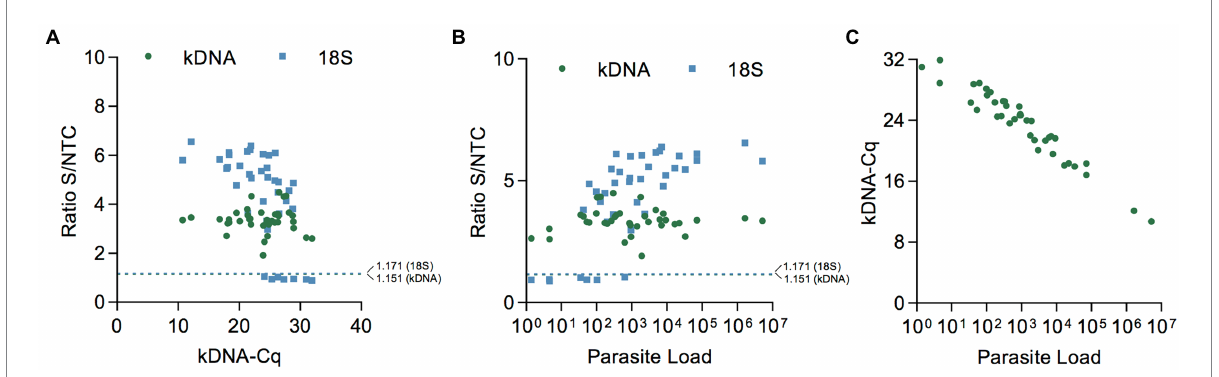
FIGURE 6 Performance evaluation of PCR/CRISPR assays across the range of parasite load levels in clinical samples. (A,B) Scatter plot showing the fluorescence ratio from Cas12a reactions for Leishmania targets in clinical samples (data shown in Figures 5B,C) versus Cq values determined by kDNA qPCR (A) or the parasite load (B) . The dashed lines shown indicate the positive threshold cutoff value (mean of the fluorescence ratio of negative clinical samples + 3SD; n = 10) for detection of Leishmania targets (cutoff value = 1.151 for kDNA and 1.171 for 18S rDNA). (C) Scatter plot showing the inverse correlation between Cq values (determined by kDNA qPCR) and the parasite load in clinical samples. The parasite load is expressed as the number of Leishmania parasites/10 6 human